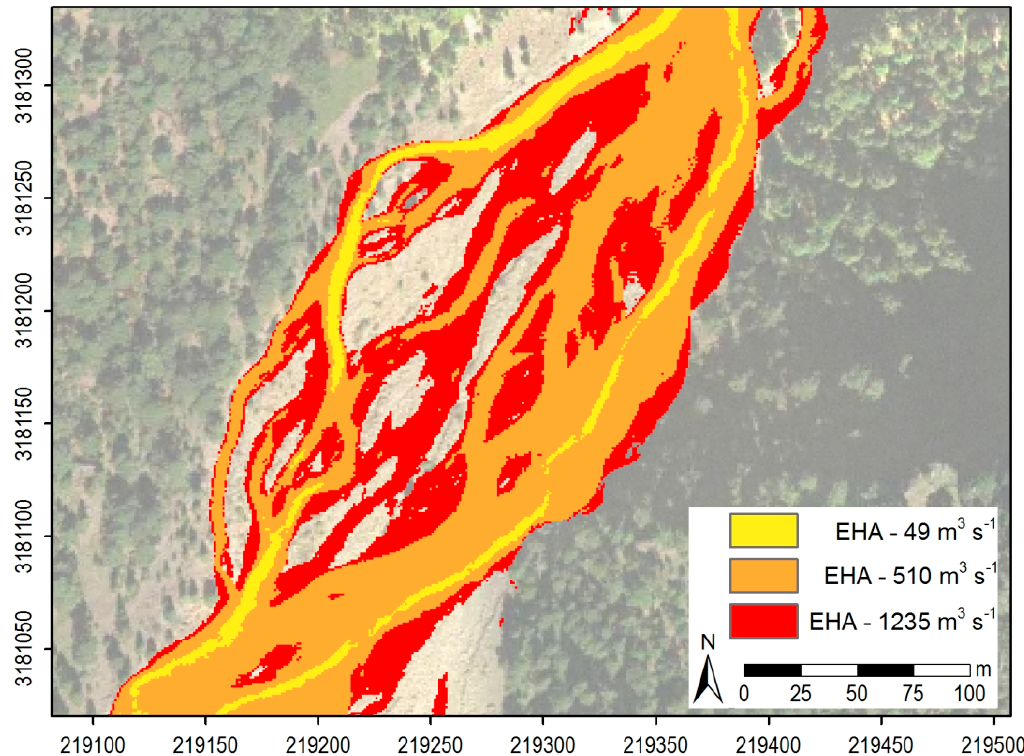
Figure 8. Extreme hazard areas (EHA, where: v × d > 2 m 2 s − 1 ) for people by loss of stability due to flow; each colour area is associated with a different peak flow hydraulic model. X- and y-axis units are meters, according to European Terrestrial Reference System 1989 (ETRS89)